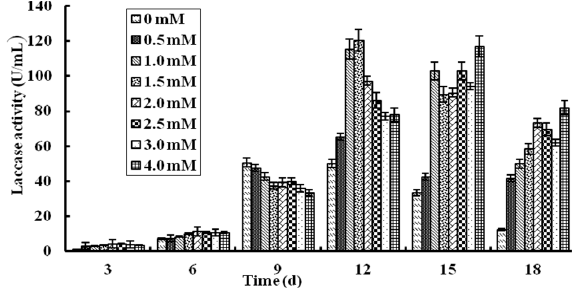
Figure 2. Effects of different concentrations of Cu 2+ ions on L. nuda laccase production in liquid fermentation. Results are presented as mean ± SD ( n = 3).